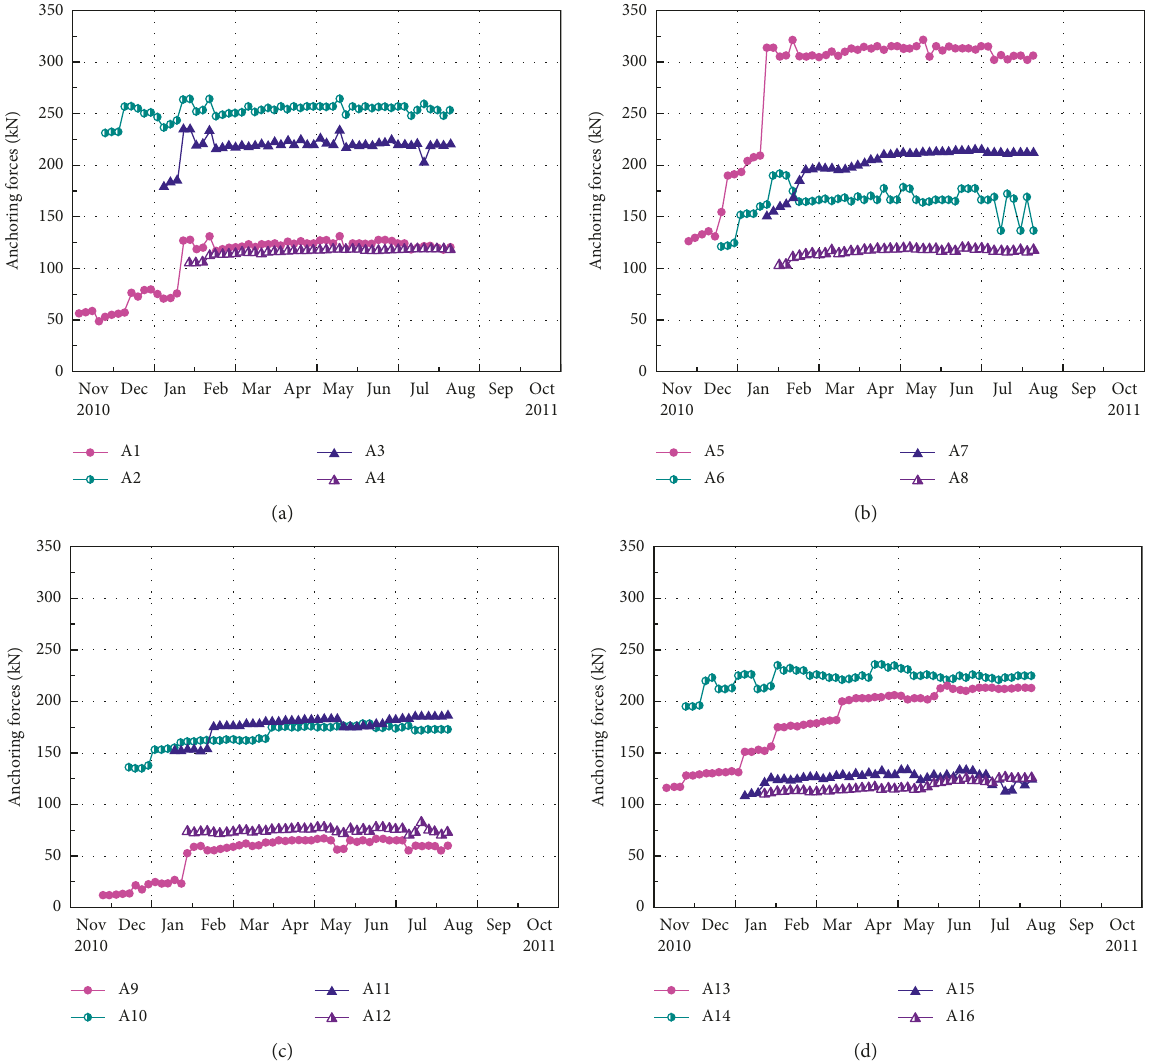
Figure 18: Axial anchoring forces during excavation. (a) The east segment. (b) The north segment. (c) The west segment. (d) The south segment.